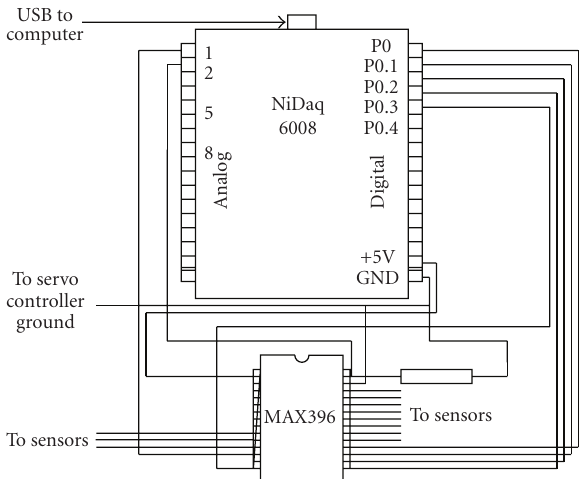
Figure 2: The circuits involved in the proprioceptive part of the LUCS Haptic Hand III. The NiDaq 6008 converts multiple analog input signals to digital signals that are conveyed to the computer via an, USB-port. The MAX396 chip is a multiplexor circuit for selection of sensor